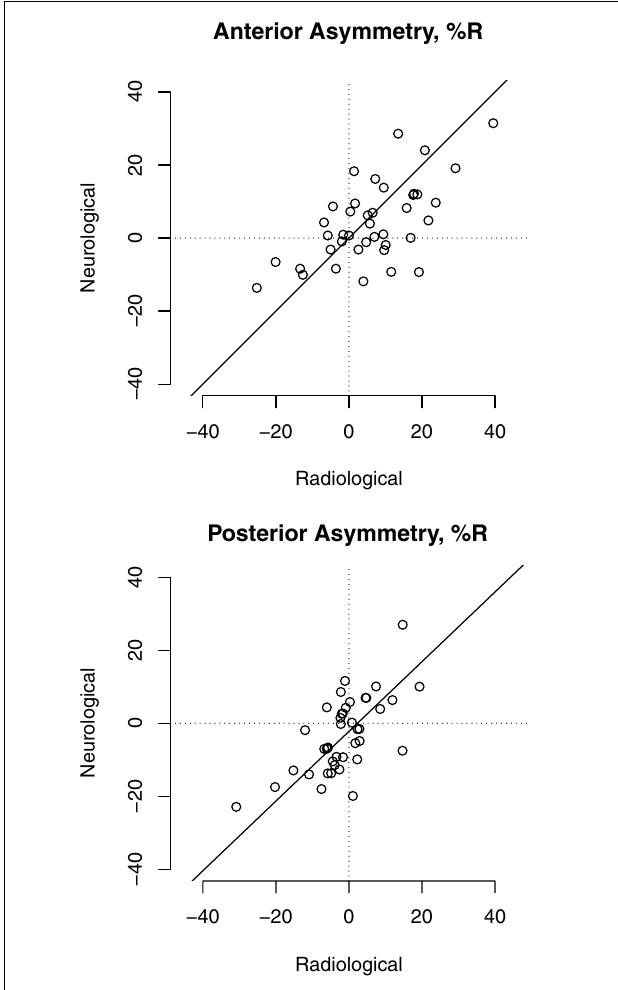
FIGURE 2 | Minimal discrepancy between measured asymmetry indices calculated from images in radiological orientation (right-on-left) versus neurological orientation (right-on-right). Systematic error would appear as a shift away from the unity line. Statistical analysis in Table 3 .